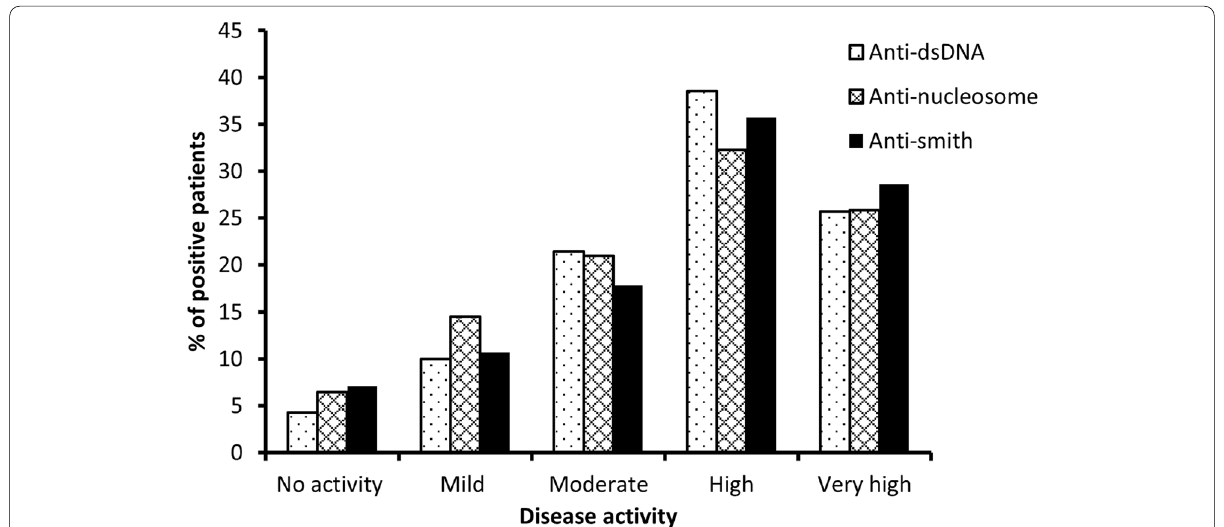
Fig. 1 Distribution of the three autoantibodies in different grades of the SLEDAI